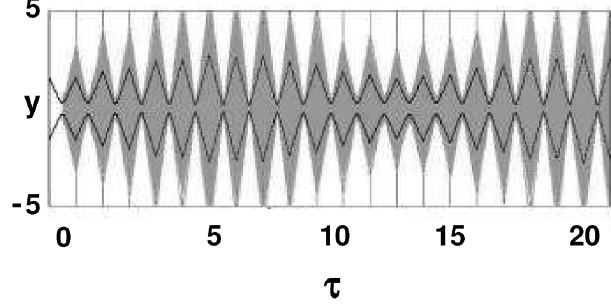
(cid:2) FIG. 6. Evolution of an optical beam in a resonator as a 0 (cid:2) 0 : 1 and right mirror function of normalized time (cid:8) , with z 0 fractional focal length change (cid:1) f=f (cid:2) (cid:4) 0 : 05 . The axes and lines are the same as Fig. 2. As in Fig. 4, the beam expands and contracts with successive